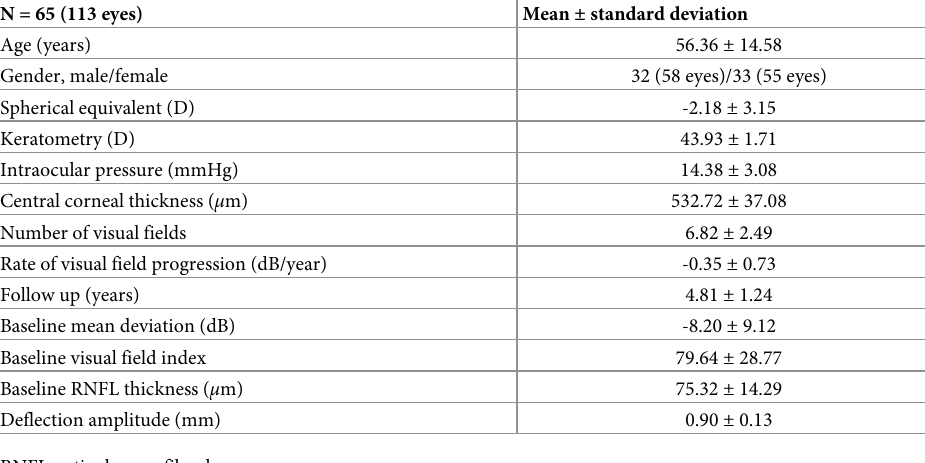
Table 1. Clinical and demographic